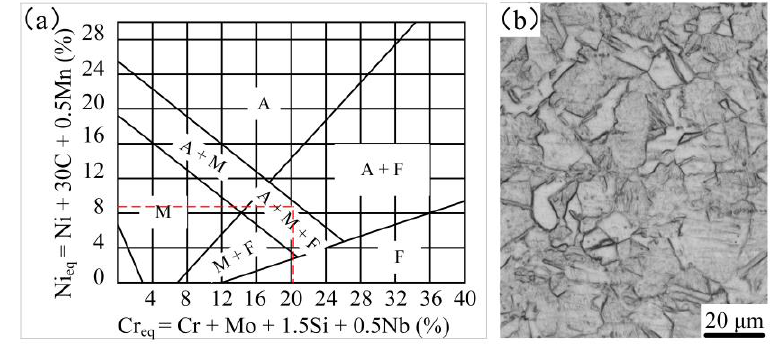
Figure 5. ( a ) Schaeffler diagram, and ( b ) microstructure of the 304 stainless steel.